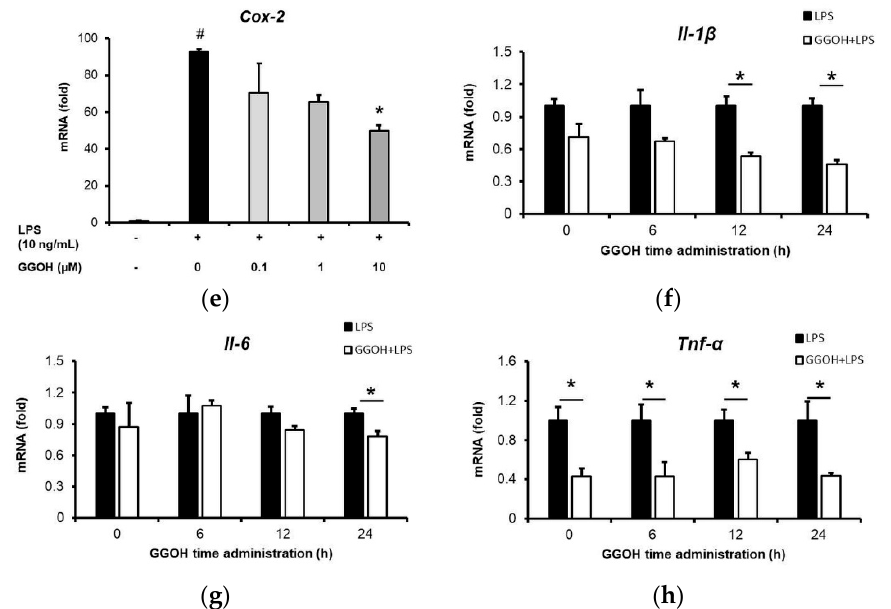
Figure 2. Suppression of pro-inflammatory cytokine mRNA expression by geranylgeraniol (GGOH). ( a ) MG6 cells pre-treated with GGOH at different concentrations for 24 h. Cell viabilities were evaluated using the WST-1 method. ( b – e ) Pro-inflammatory cytokine mRNA expression levels in MG6 cells pre-treated with GGOH at different concentrations for 24 h followed by LPS (10 ng/mL) treatment for 3 h. ( f – h ) Pro-inflammatory cytokine mRNA expression levels in MG6 cells pre-treated with GGOH (10 µM) at different times followed by LPS treatment (10 ng/mL) for 3 h. Closed bar, LPS-only treated groups; open bar, GGOH pre-treated groups. The mRNA levels were measured via quantitative reverse transcriptase-PCR, normalized to Eef1a1 (the internal standard), and expressed as fold-changes relative to control cell values or the values corresponding to LPS-only treated MG6 cells. Data are presented as the mean ± S.E.M, n = 3; # p < 0.05 vs. untreated control; * p < 0.05 vs. LPS-only treated group).